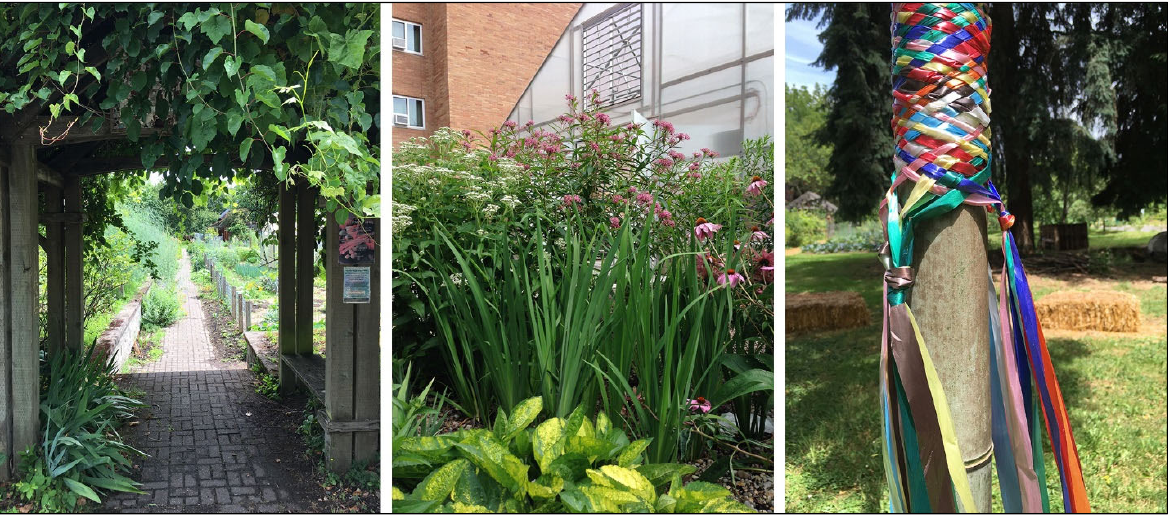
Figure 5. Types of Attractions: Entryways and Edges (left), Ornamental Demonstration Planting (Middle), Farm Craft